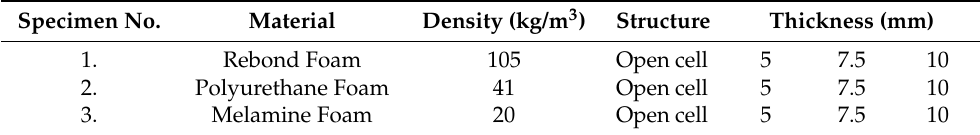
Table 4. Detailed specification of open cell foam samples used in the experimentation.